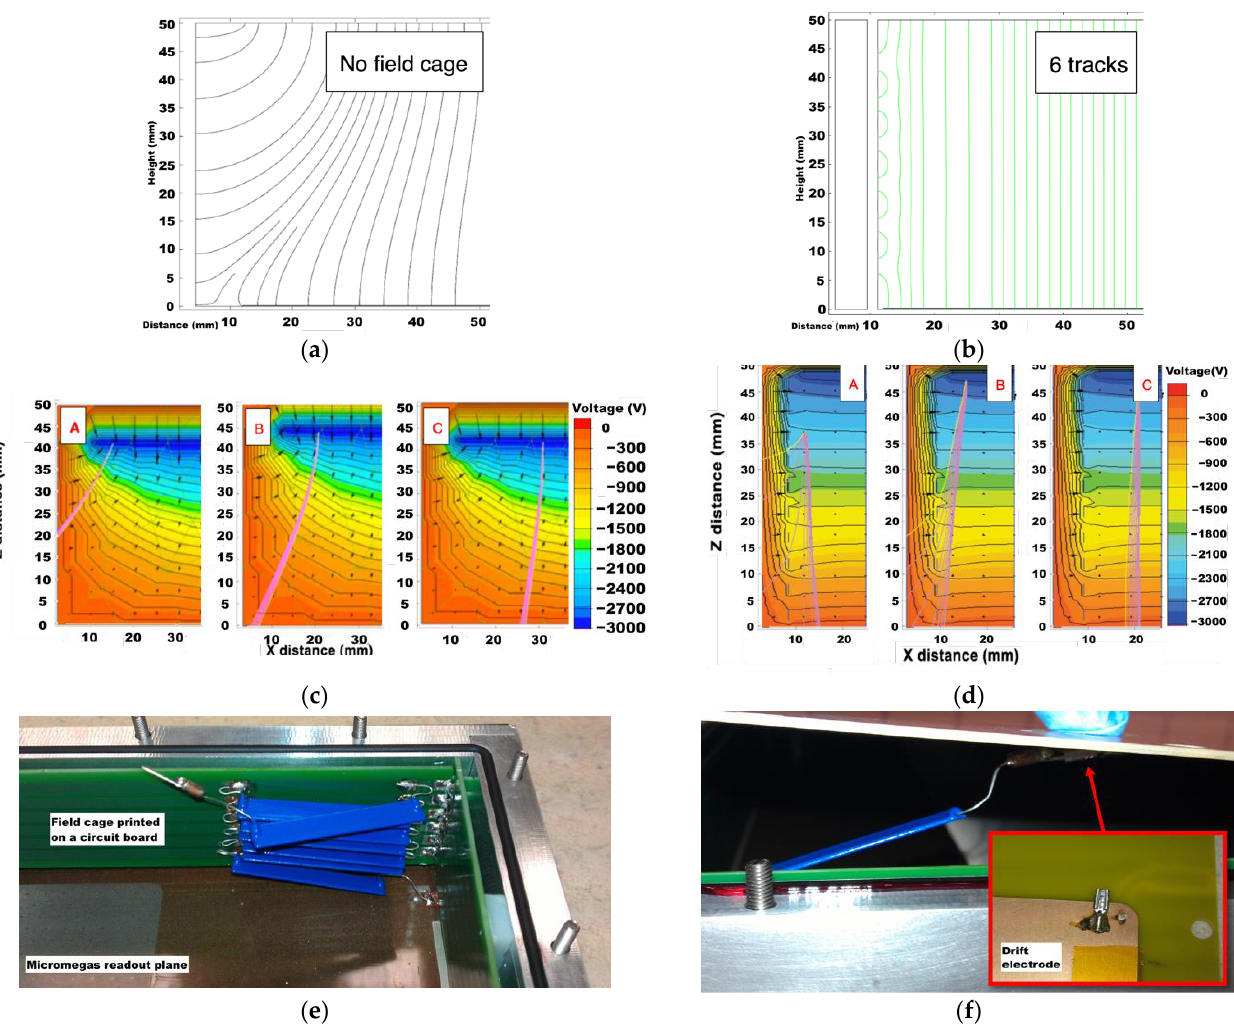
Figure 2. Representation of the field lines within the drift volume without ( a ) and with ( b ) the field cage. Simulation of the electron drift path (pink lines) inside the TPC without ( c ) and with ( d ) field cage. ( e ) Inner view of the TPC and ( f ) connection to the drift